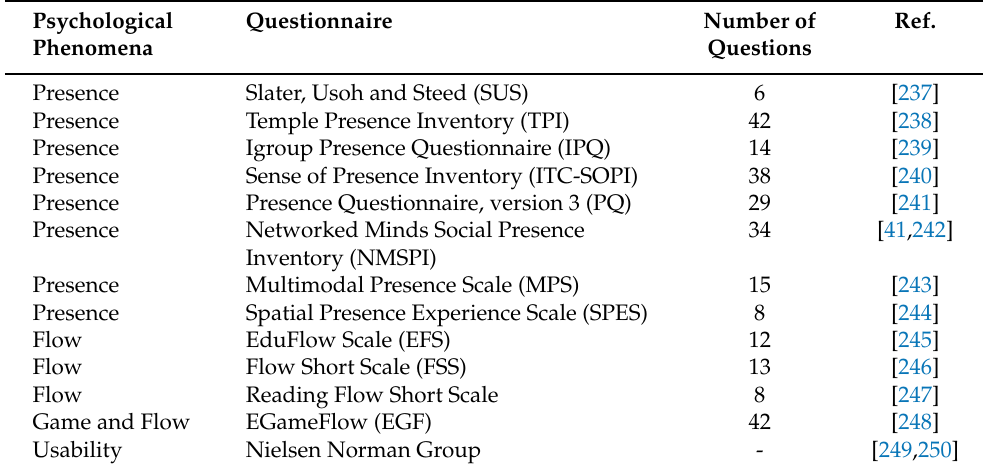
Table 11. List of questionnaires to assess presence, flow, and